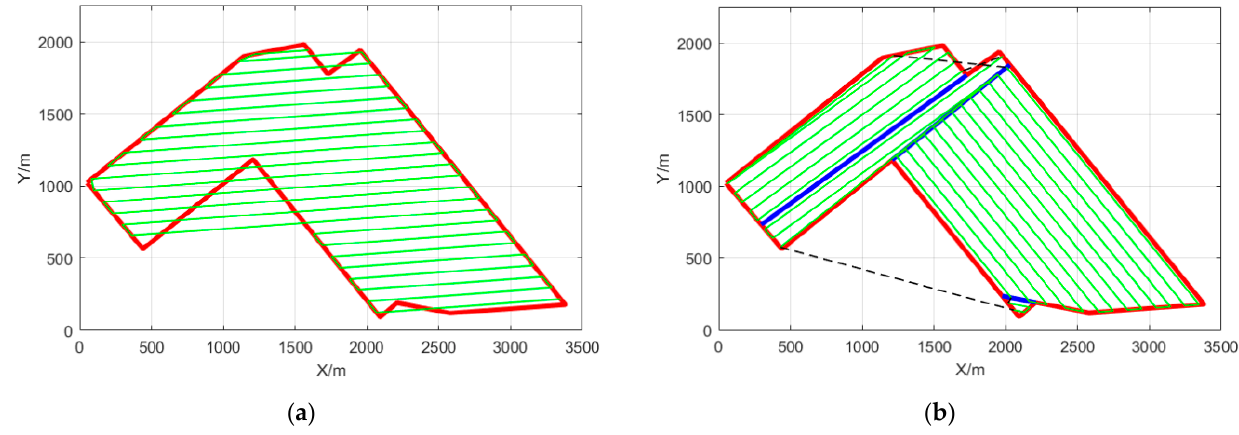
Figure 24. Coverage path before and after ROD. ( a ) Coverage path before ROD; ( b ) coverage path after ROD.